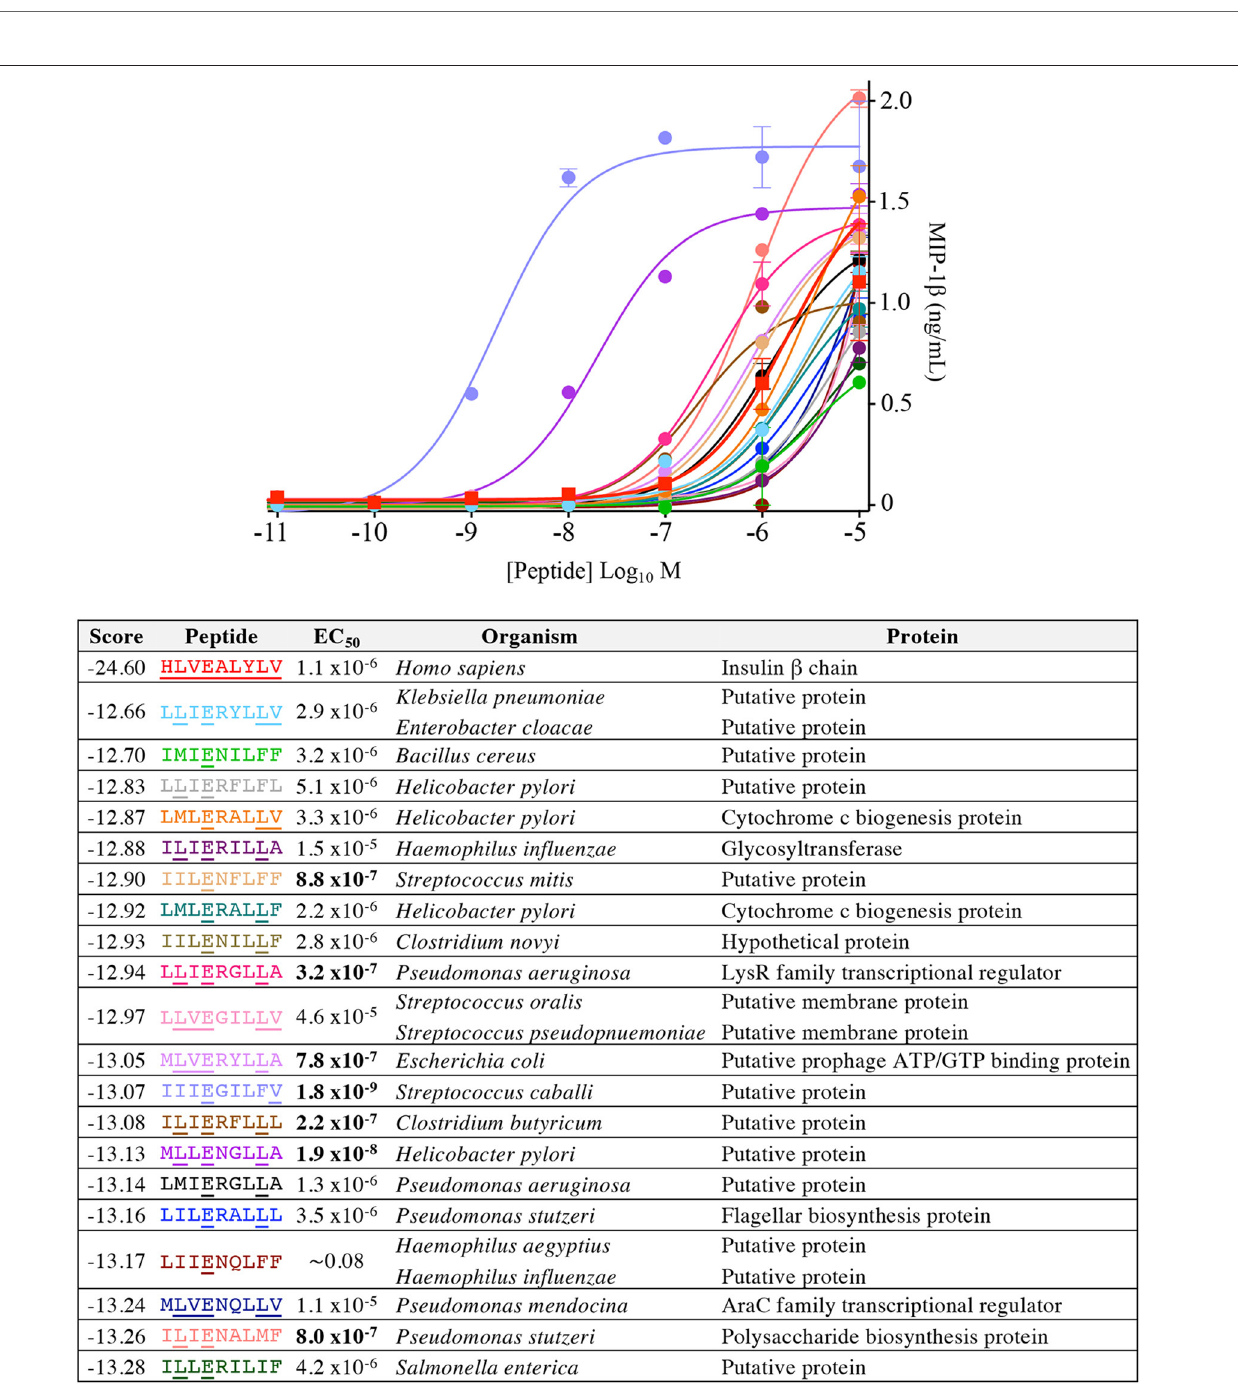
FIGURE 9 | InsB4 recognizes bacterial peptides with increased sensitivity relative to index insulin peptide. The 20 top-scoring peptides from category II (i.e., confirmed pathogenic) bacterial species were tested overnight for activation on InsB4 by MIP-1 β ELISA. The likelihood scores and EC 50 of peptide (M) activation are shown. Putative proteins are the product of predicted open reading frames from the genome sequence of the species indicated. Bold EC 50 more potent than the index peptide. ∼ = ambiguous EC 50 based on GraphPad Prism software analysis. Amino acid residues that are the same for each bacterial peptide and the insulin index peptide (HLVEALYLV) are